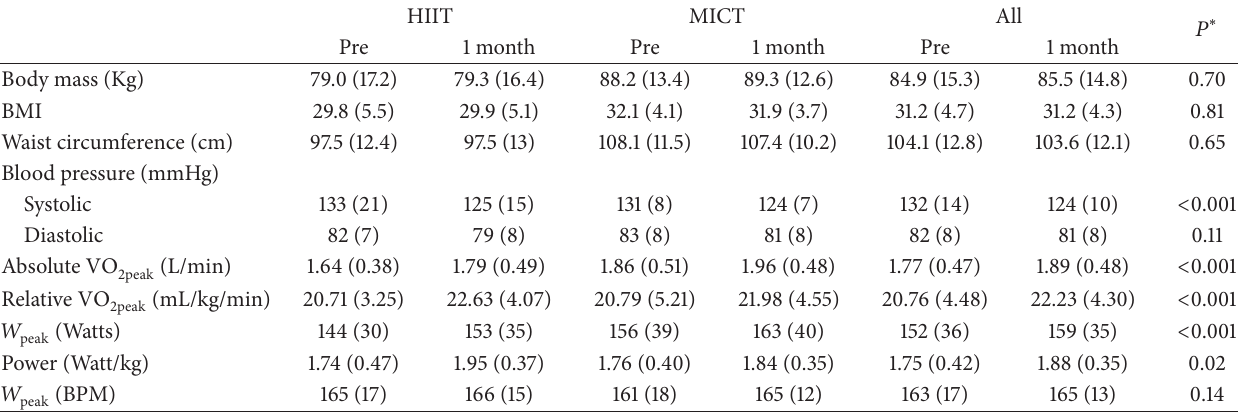
Table 3: Changes in fitness and cardiometabolic parameters (mean [SD]) before and 1 month following intervention for study participants randomized to high-intensity interval training (HIIT, 𝑛 = 10 ) and moderate-intensity continuous exercise (MICT, 𝑛 = 16 ) and overall ( 𝑛 = 26 ) effect of time. The current results represent per-protocol